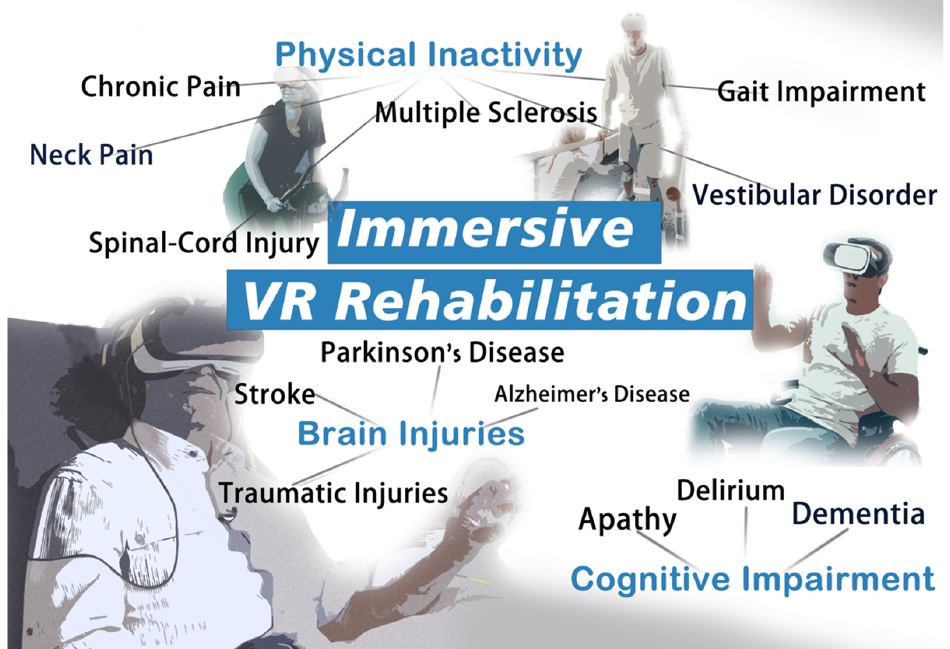
Figure 1. The main symptoms in immersive VR rehabilitation.